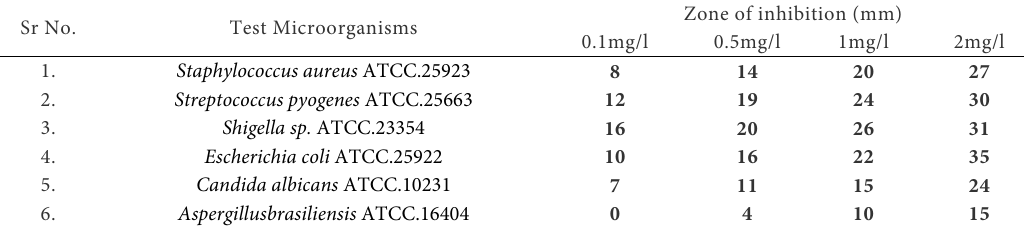
Table 6. Antimicrobial activity by different CuNPs